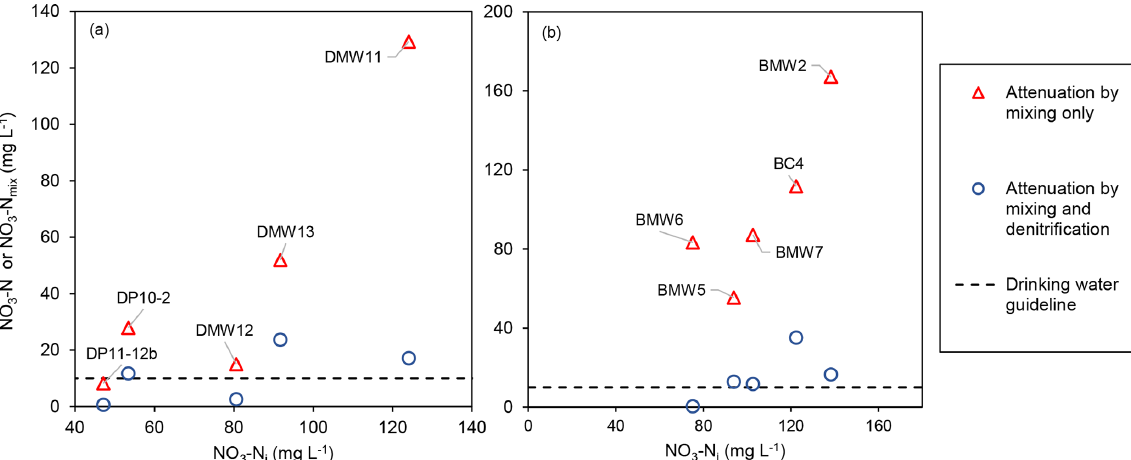
Figure 8. Measured concentrations of NO 3 − N (blue circles – attenuation by mixing and denitrification) and NO 3 − N mix (red triangles – attenuation by mixing only) vs. mid-range estimate of NO 3 − N i at (a) CFO1 and (b) CFO4. Dashed lines are drinking water guideline (10mgL − 1 of NO 3 −